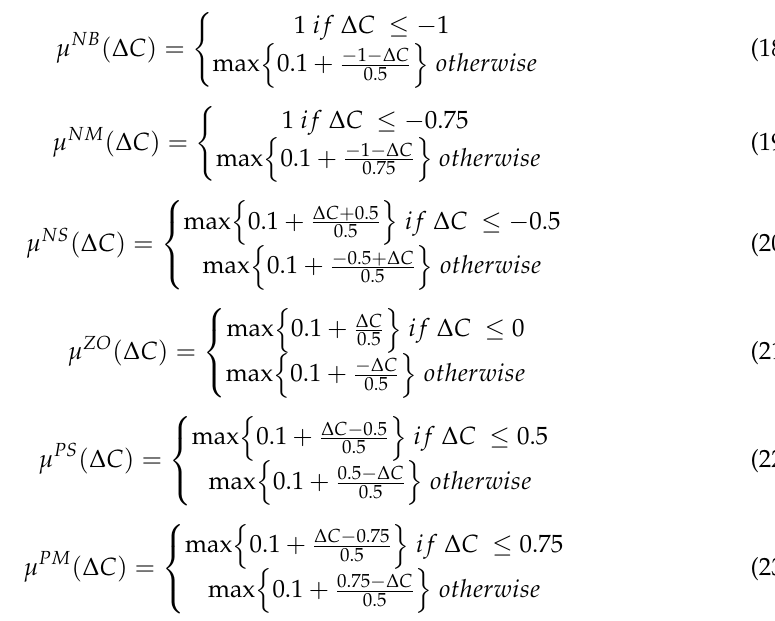
Figure 14. Exit membership Δ C.